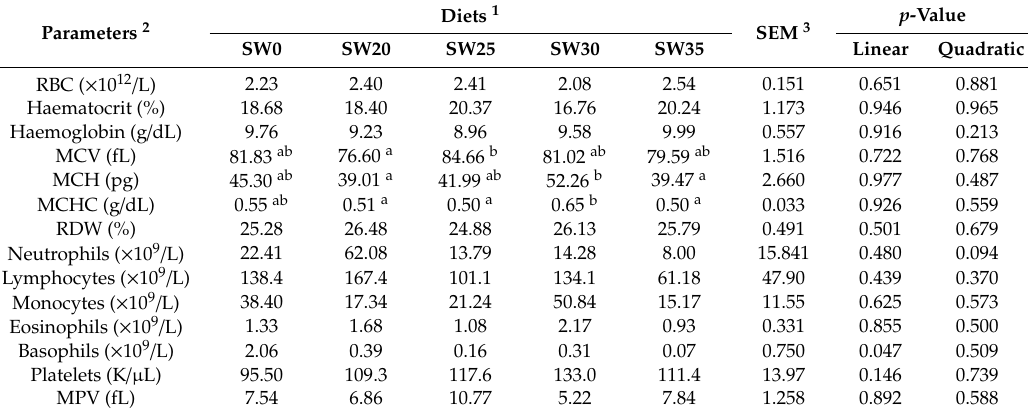
Table 7. Haematological parameters of Boschveld indigenous hens fed diets containing seaweed meal. Parameters 2